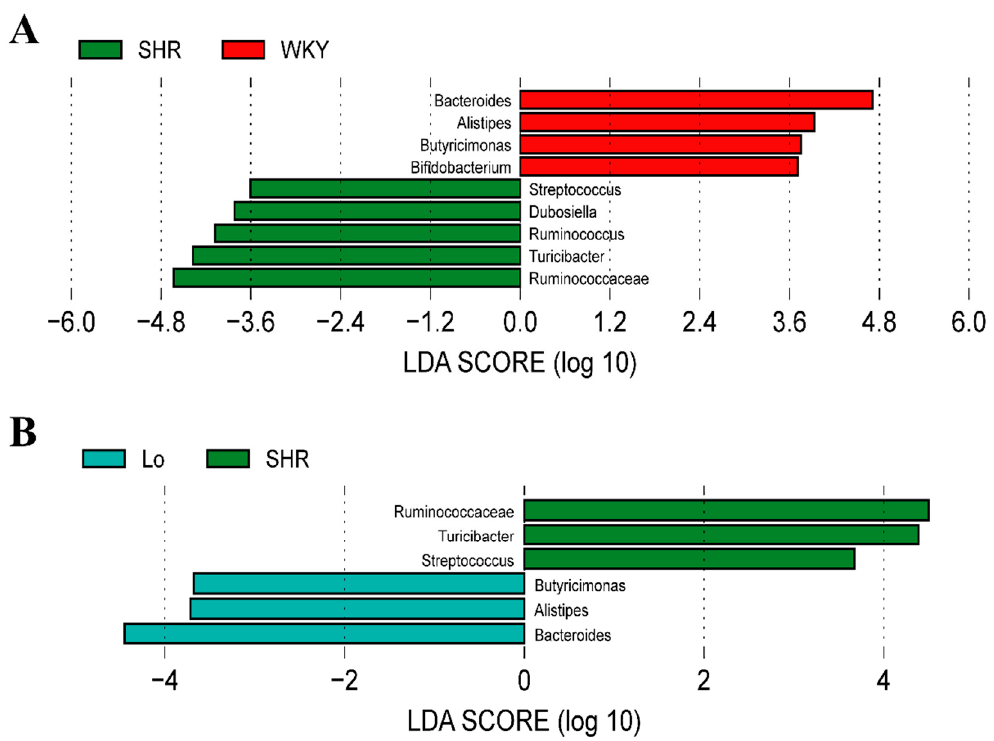
Figure 7. The histogram of the linear discriminant analysis (LDA) value distribution at genus level of gut microbiota, which was used to find biomarkers with statistical differences. ( A ) Bacterial genera with significant difference in abundance between WKY and SHR groups. ( B ) Bacterial genera with significant difference in abundance between SHR-losartan and SHR groups.